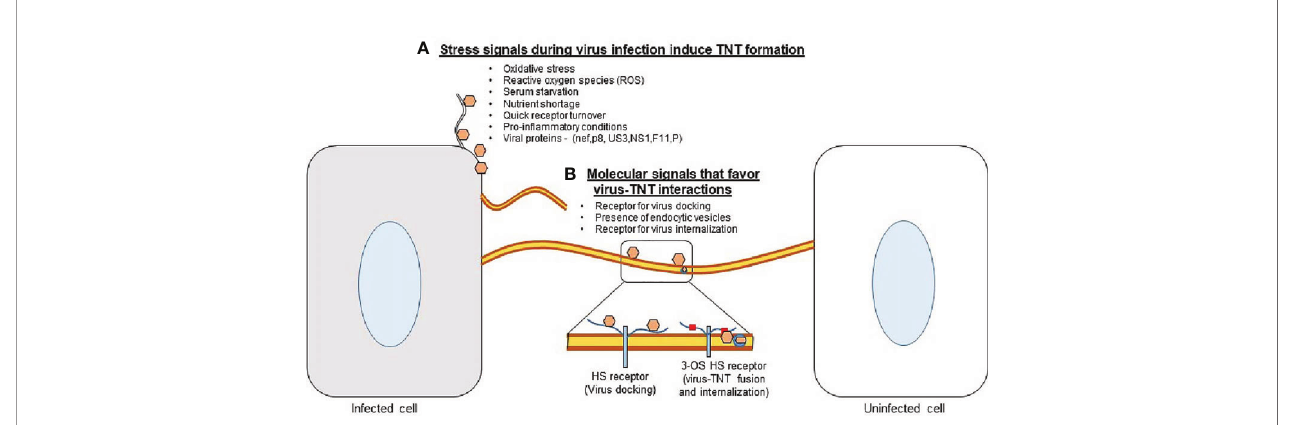
FIGURE 1 | Tunneling nanotubes (TNTs) - a major platform for the viruses to scan the neighborhood for successful entry and spread. (A) Stress conditions (ROS, a lack of nutrients, and possibly a quick receptor turnover) together with the in fl ux of viruses induce the Rho GTPase-mediated signaling pathways which then trigger the induction of TNTs. (B) The presence of viral receptor such as heparan sulfate (HS) provides an opportunity for the virion to dock and/or surf on TNTs. In addition, the presence of 3-O sulfated HS receptor may induce direct virus-TNT fusion or receptor mediated endocytosis to promote virus